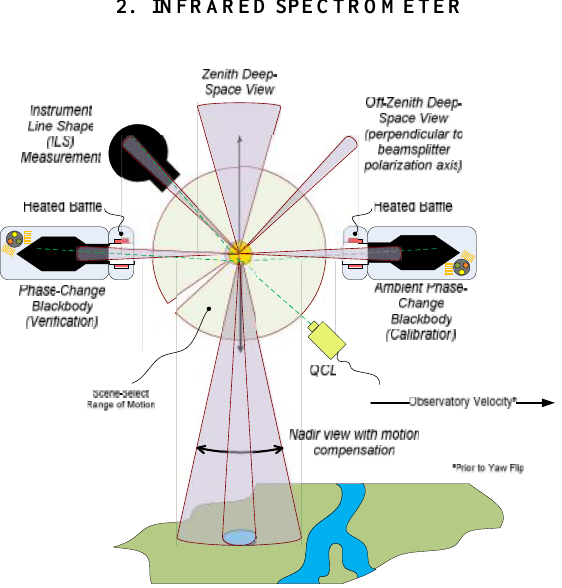
Figure 5. IR Spectrometer concept showing the variety of validation sources that are routinely viewed